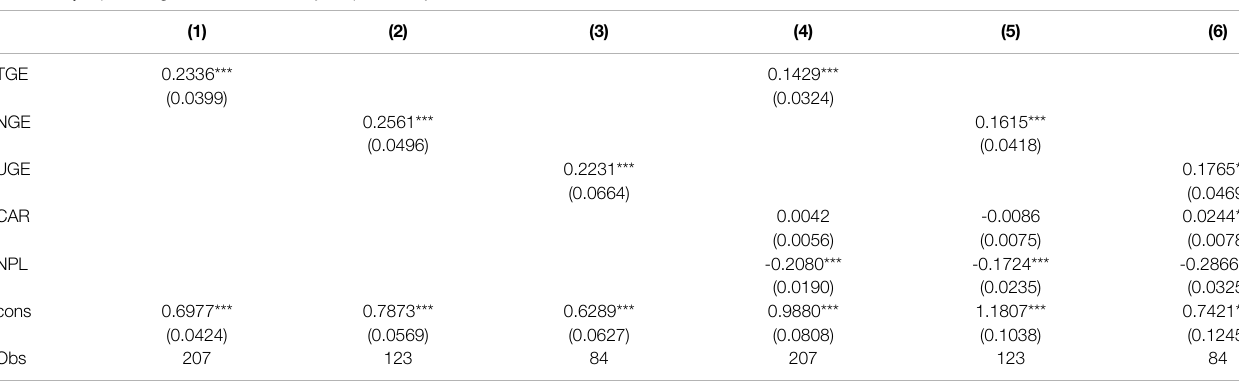
TABLE 9 | Impact of green credit ef fi ciency on pro fi tability in commercial